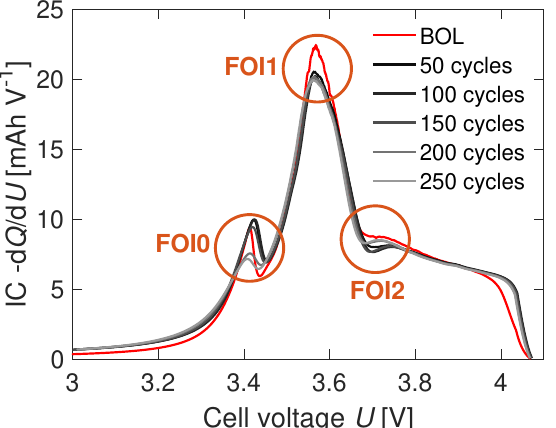
Figure 2. Defined features of interest (FOIs) of the incremental capacity (IC) curves. Three characteristic extrema are detected: the first peak (FOI0) at U ≈ 3.4V, the main peak FOI1 at U ≈ 3.6V, and the local minimum FOI2 at about U = 3.7V. The figure exemplary shows the changes in the FOIs for a cyclically aged coin